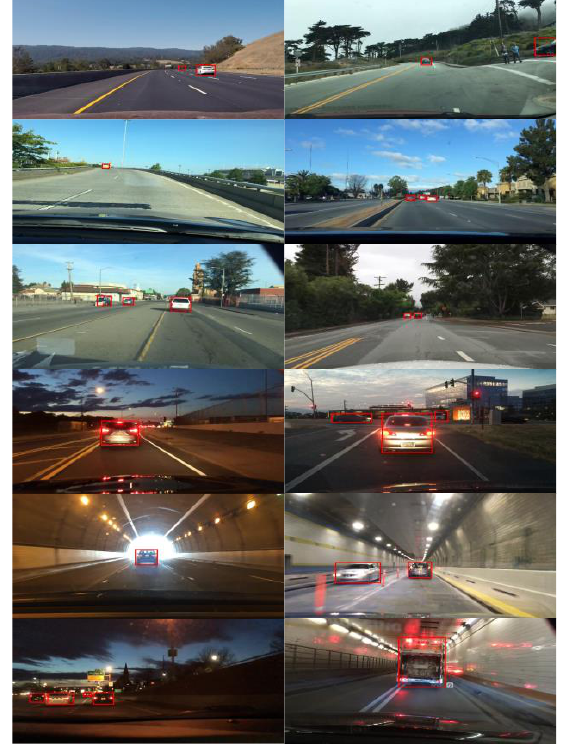
Figure 17. Effect diagram of detection under good driving environment.